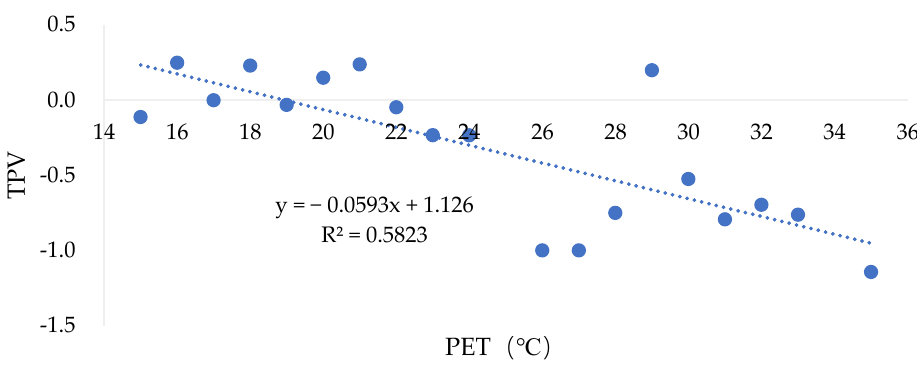
Figure 10. Relationship between TPV and PET.